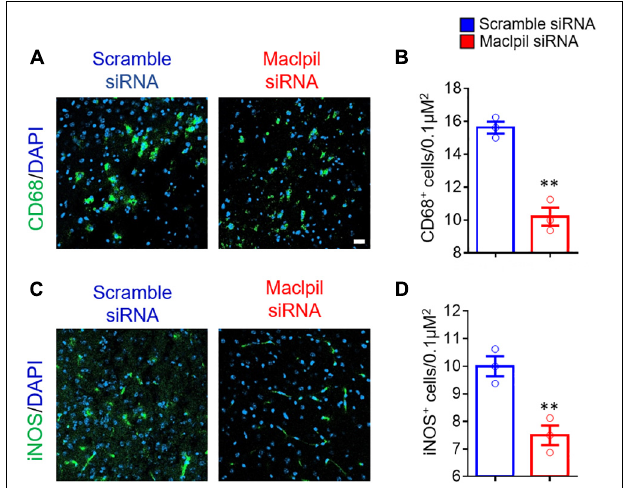
FIGURE 3 | siRNA silencing Maclpil reduces cells expressing CD68 and iNOS in ischemic infraction area. Brain sections were stained with antibodies against CD68 and iNOS, respectively, counterstained with DAPI for nuclei, and imaged on a confocal microscope. (A,B) Representative staining images for CD68 (A) and CD68 + cell density estimated as positively stained cells/0.1 µ m 2 (B) . (C,D) Representative staining images for iNOS (C) and iNOS + cell density quantified as positively stained cells/0.1 µ m 2 (D) . All data are presented as mean and SD from 3 mice in each group. Student’s t -test, ∗∗ p < 0.01 compared to scramble siRNA